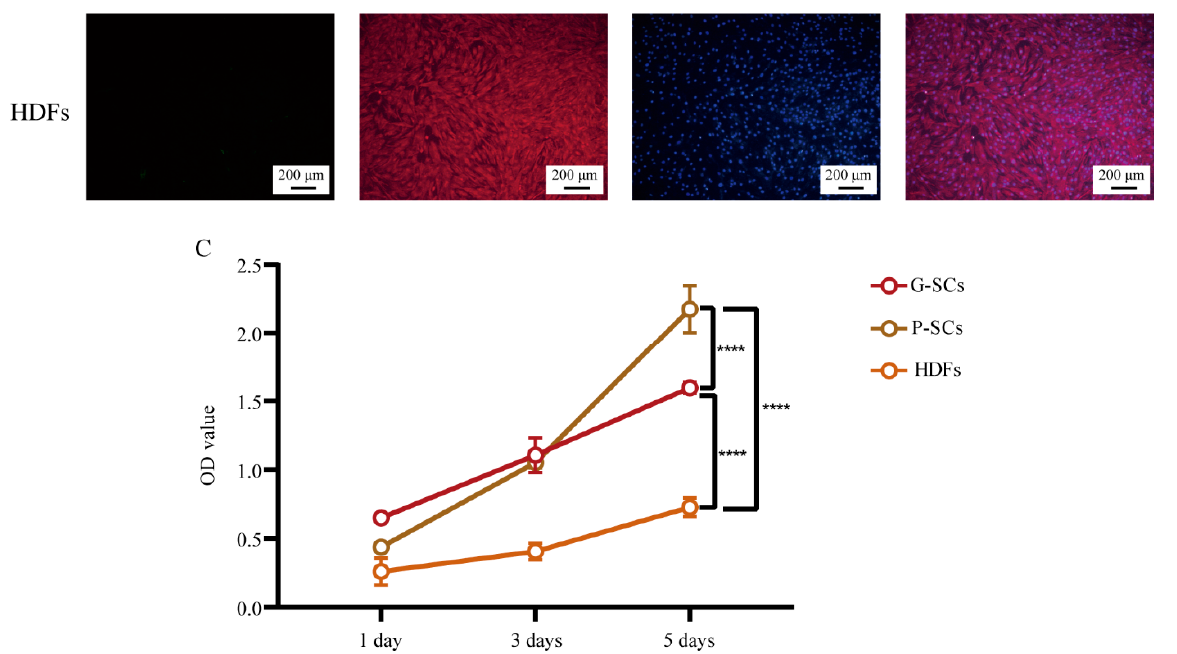
Figure 1. The cell morphology, cell viability, and cellular component of G-SCs, P-SCs, and HDFs were confirmed. ( A ) The cell morphology of G-SCs, P-SCs, and HDFs was confirmed by Giemsa staining. ( B ) The cellular component of G-SCs, P-SCs, and HDFs was confirmed by IF. ( C ) The cell viability of G-SCs, P-SCs, and HDFs was examined by MTS assay. Data are shown as the mean ± s.d. (s.d., standard deviation), n = 4. Statistical analysis was performed by two-way ANOVA, **** indicates p < 0.0001.